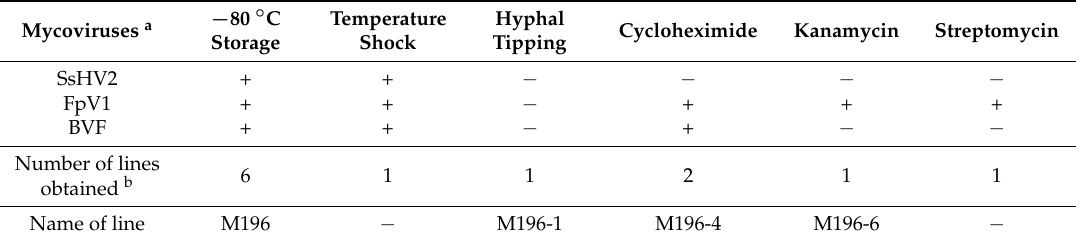
Table 1. Presence (+) or absence ( − ) of mycoviruses from isogenic lines of M. fructicola M196 after treatment. The antibiotic treatments were combined with hyphal